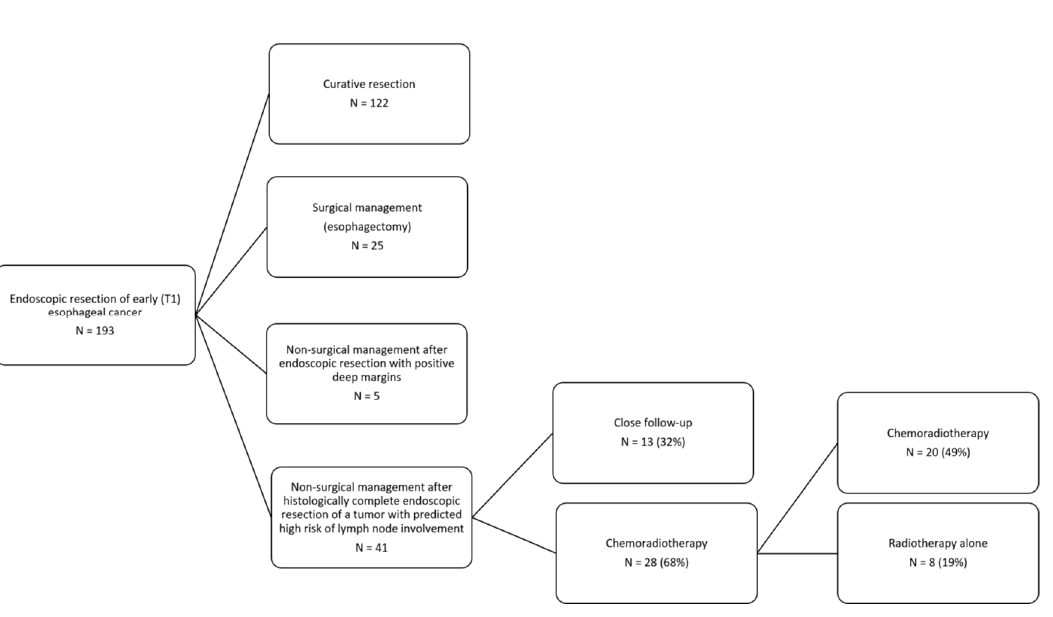
Table 2. Histological characteristics of the lesions in the 13 patients of the close follow-up group.